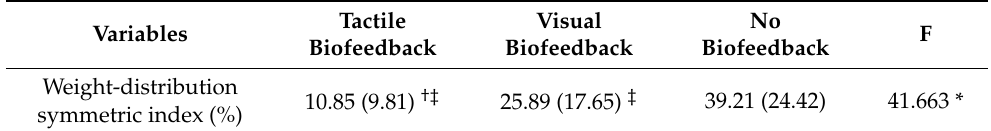
Tactile Visual No F Biofeedback Biofeedback Biofeedback